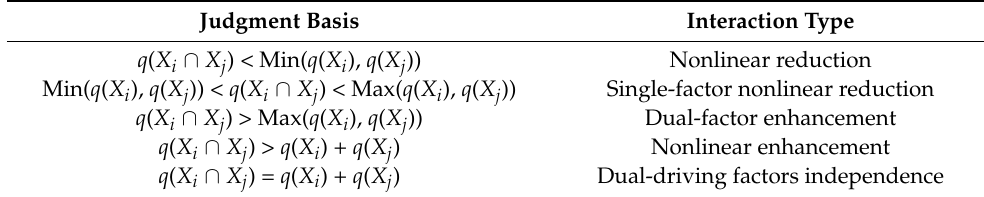
Table 2. Interaction type determination